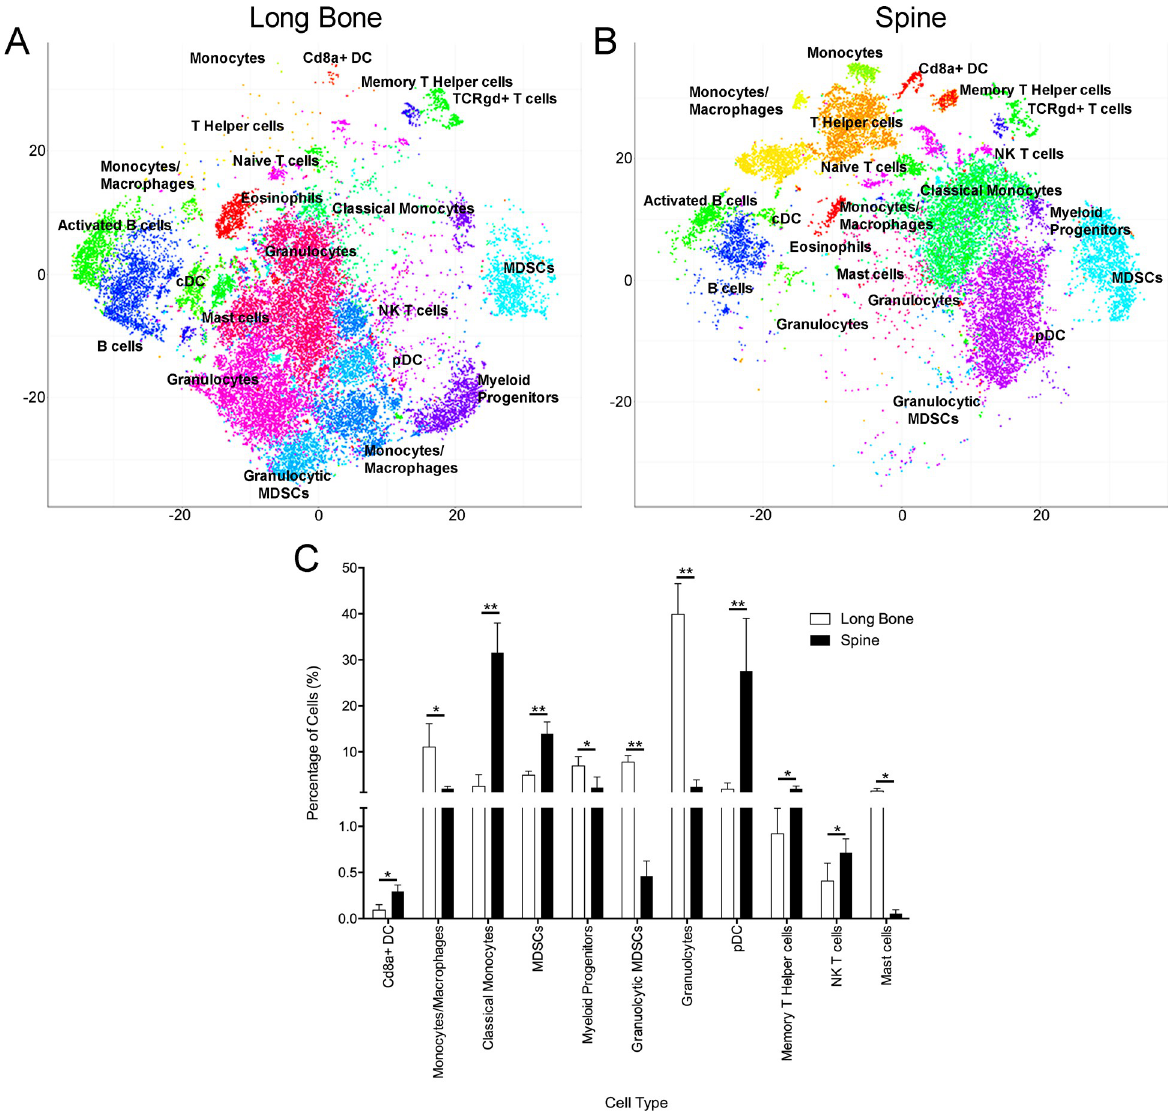
Fig 1. Characterization of the immune microenvironments of mouse vertebra and femur bone marrow using CyTOF. Representative t-SNE plots show PhenoGraph clusters for ( A ) long bone and ( B ) spinal bone marrow. ( C ) Frequencies of statistically different immune cell populations between the two bone marrow samples. All cell types listed were statistically significant; p < 0.05. n = 5, percent of cells (SD, � denotes p < 0.05, �� denotes p <